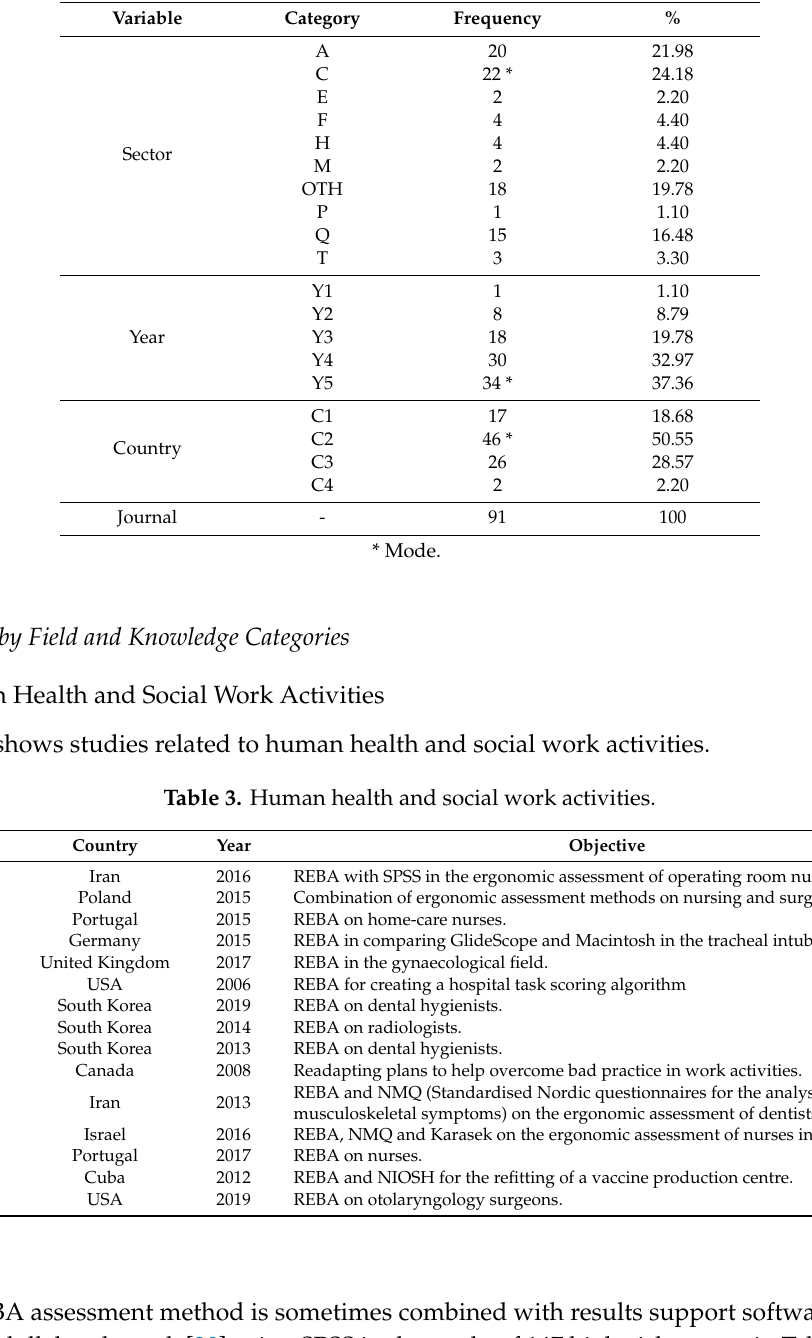
Table 2. Category frequencies.